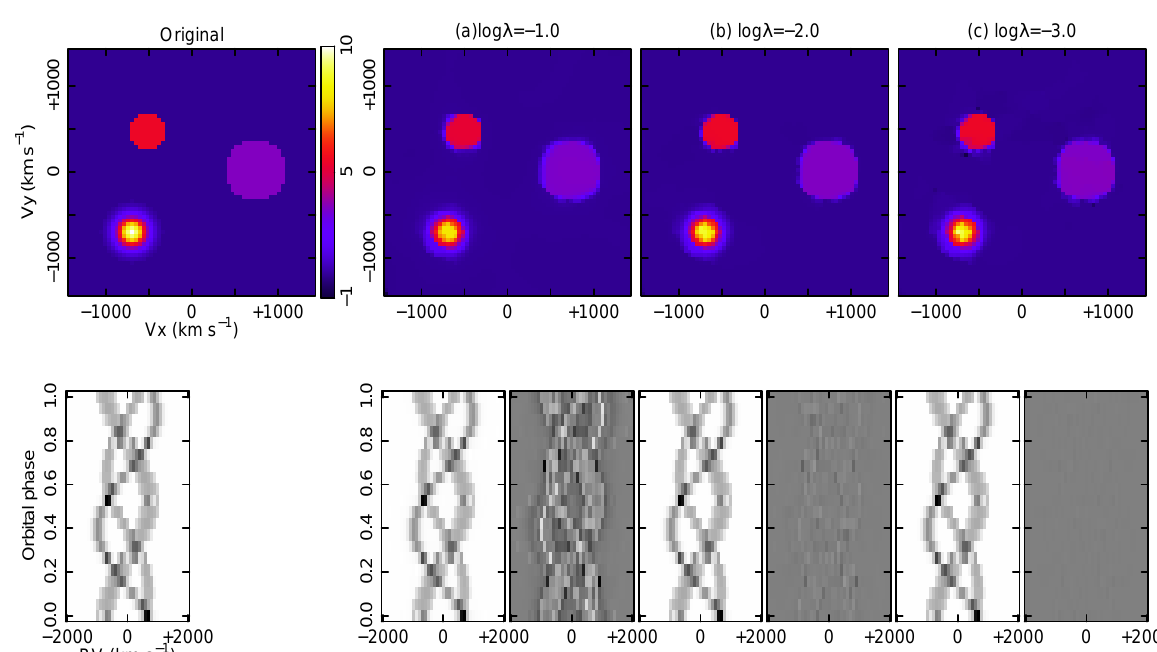
Figure 1: Results of DTTVM using an artificial map having three spots. The artificial map is depicted in the upper left-most panel. The simulated spectra from the map is shown in the lower left-most panel. Three sets of results are shown with different λ , which is indicated by the top of the figure. For each set, the estimated Doppler map is shown in the upper panel. The lower left and right panels are the model spectra and residuals between the original and model spectra,